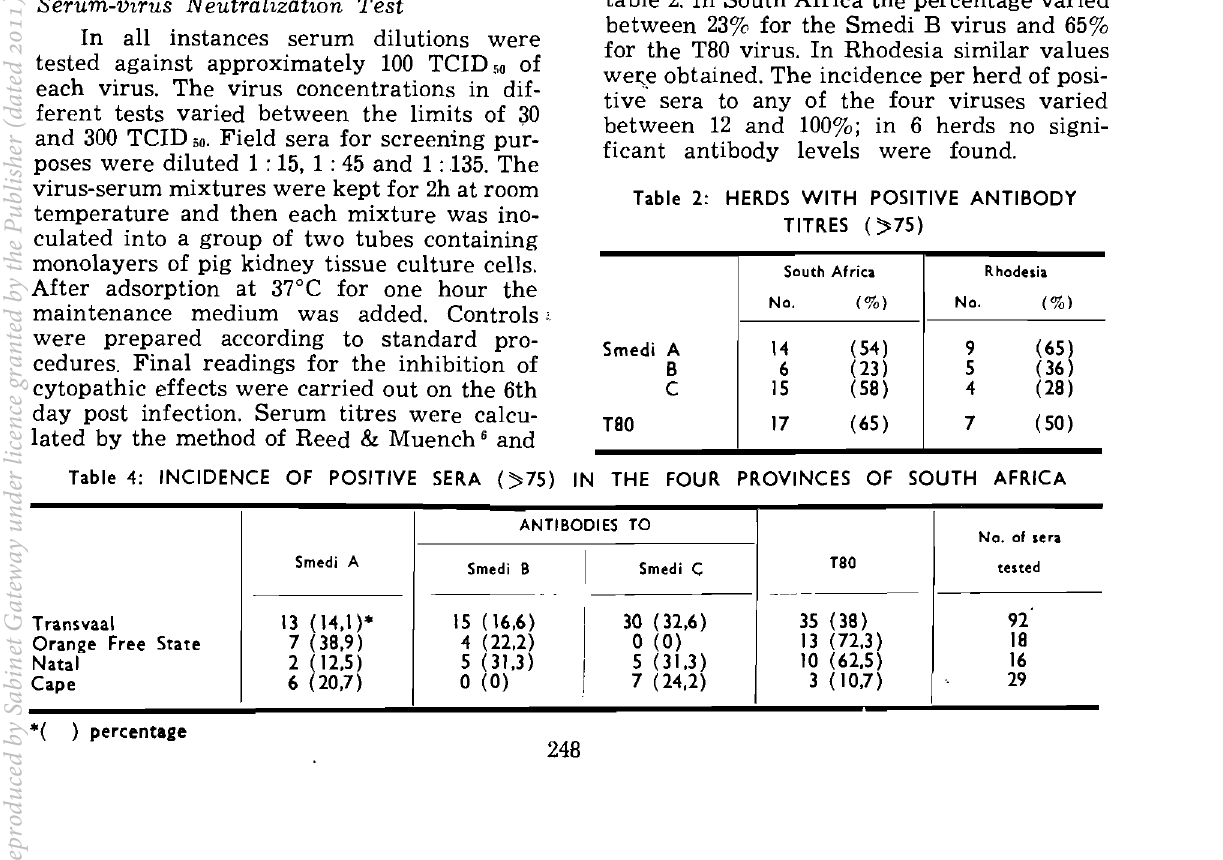
table 2. In South Africa the percentage varied